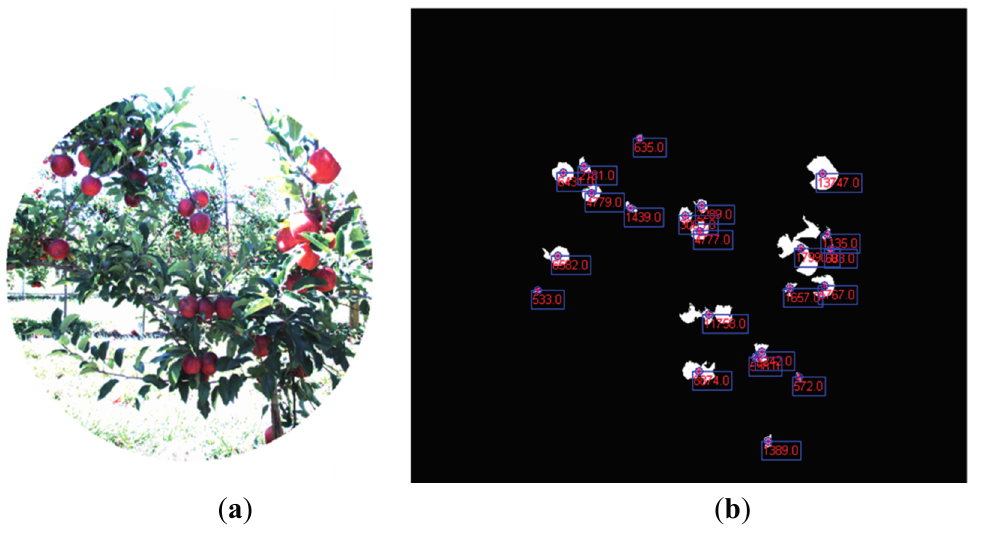
Figure 6. Apple orchard. ( a ) RGB image; ( b ) Centroid and area calculation for each